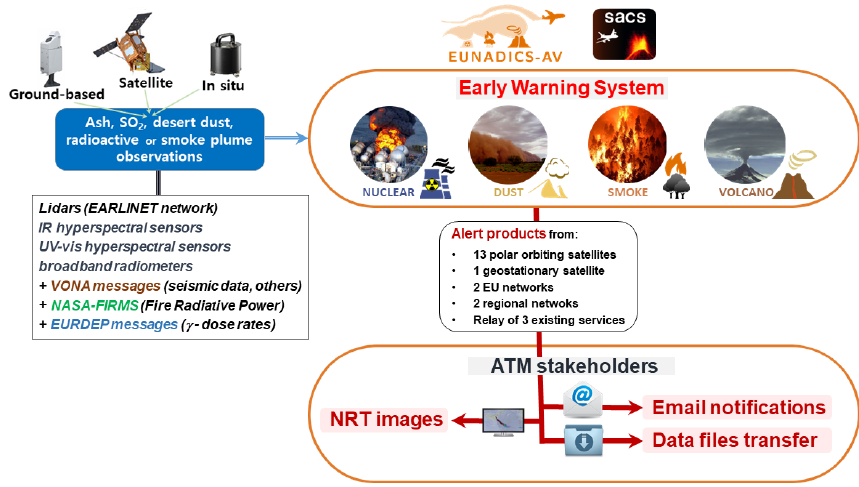
Figure 20. Illustration of the mechanism of the EUNADICS-AV